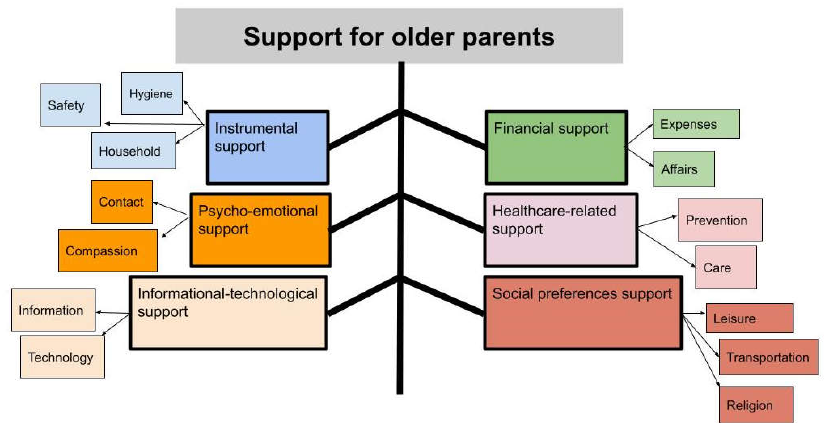
Figure 1. The aspects of family support for older parents in home care.